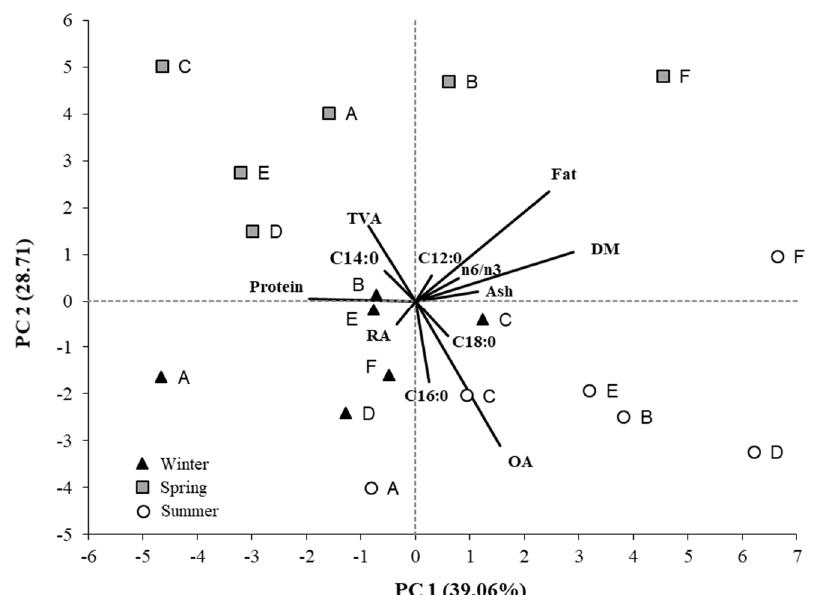
Figure 1. PCA analysis based on chemical traits and FA composition of cheese for production season. The length of each vector is proportional to its contribution to the main components. Abbreviations: DM = dry matter; OA = oleic acid; TVA = trans-vaccenic acid; A (A_org), B (B_org), C, D, E and F = farms.